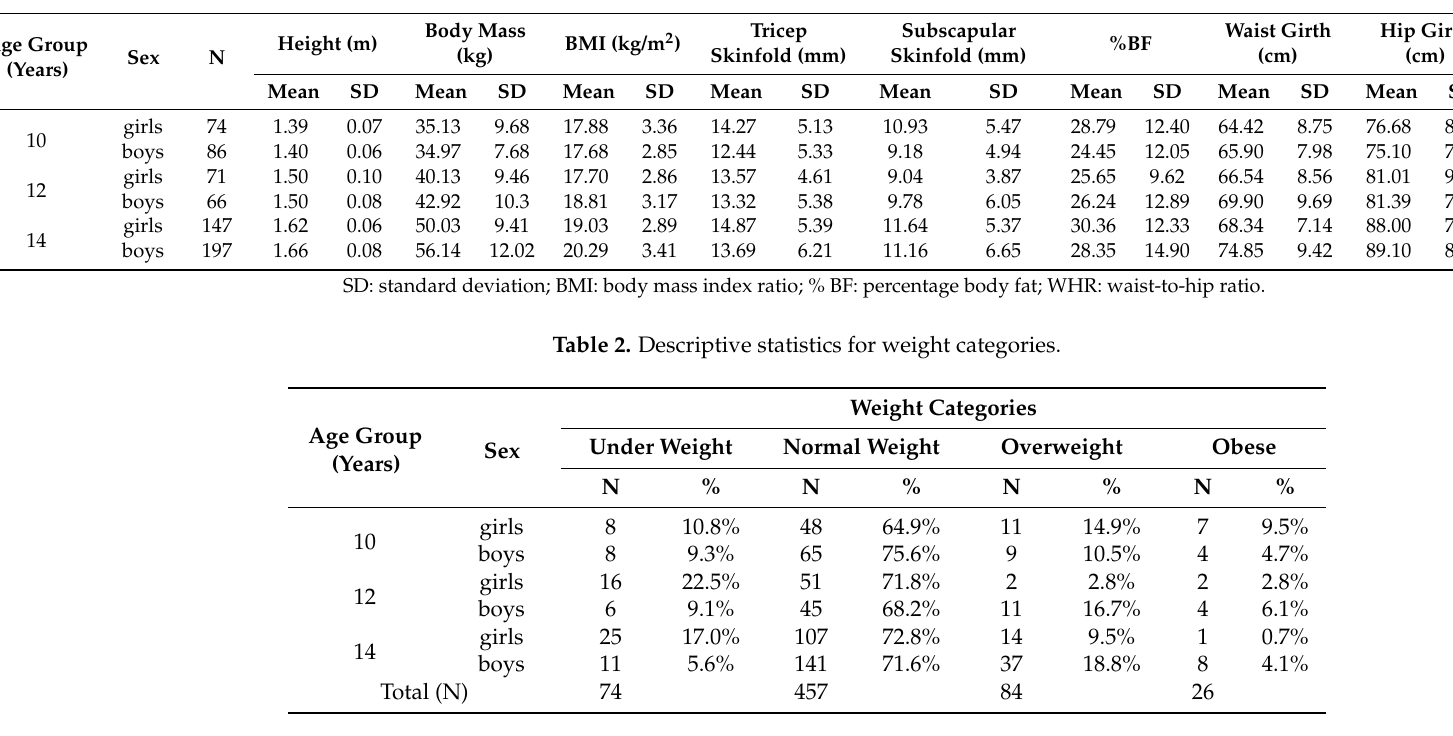
Table 3. Descriptive statistics of physical